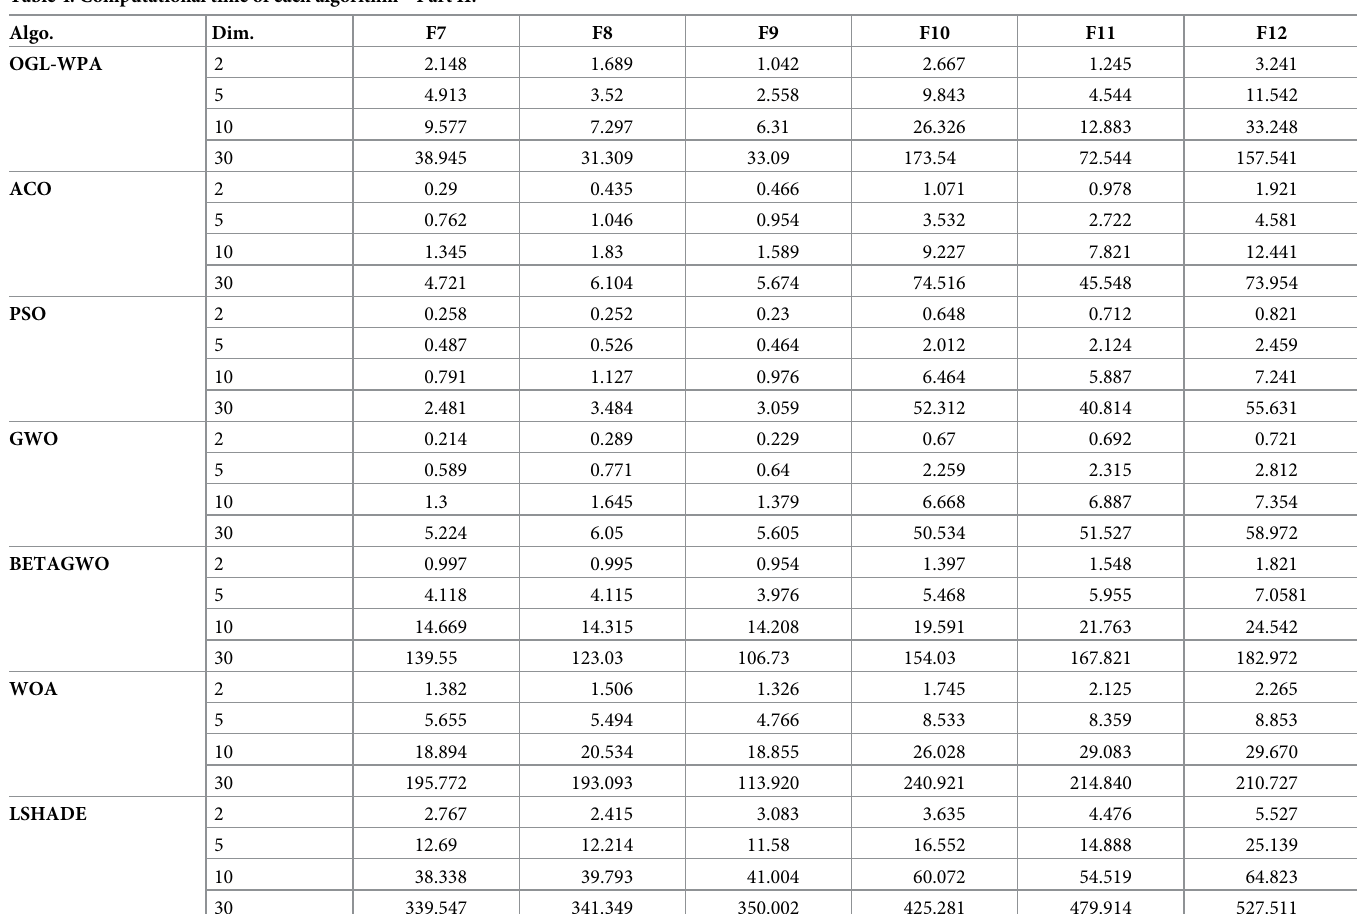
Table 4. Computational time of each algorithm—Part II. Algo. Dim.